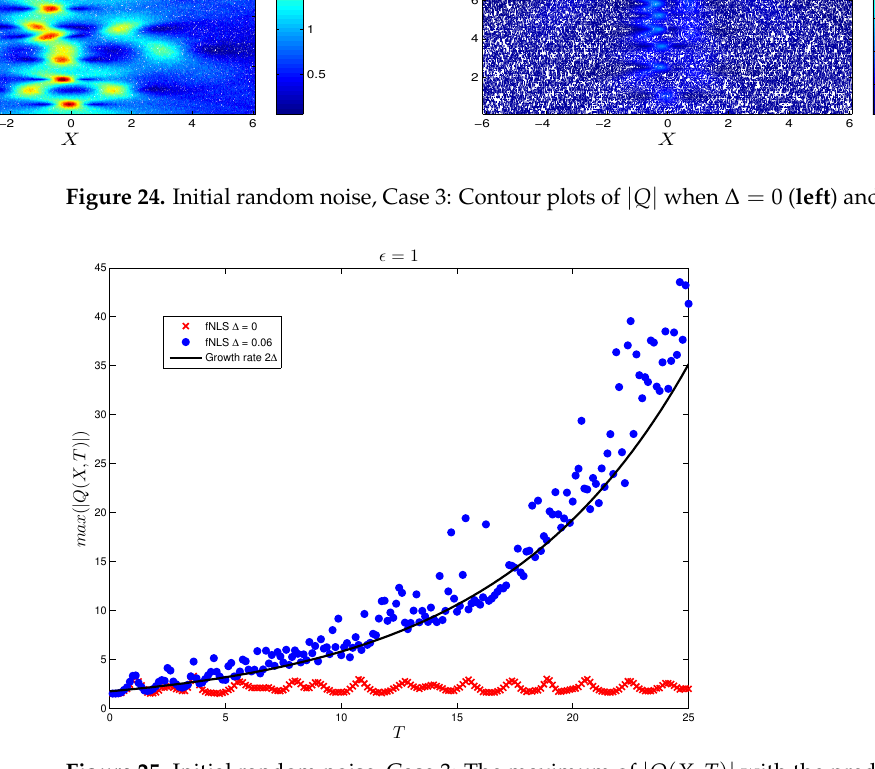
Figure 25. Initial random noise, Case 3: The maximum of | Q ( X , T ) | with the predicted growth rate 2 ∆ when γ = 0.5, (cid:101) = 1.0, and ∆ = 0.06. Case 4 : The results with initial random noise are shown in Figure 26 for M = 1, (cid:101) =